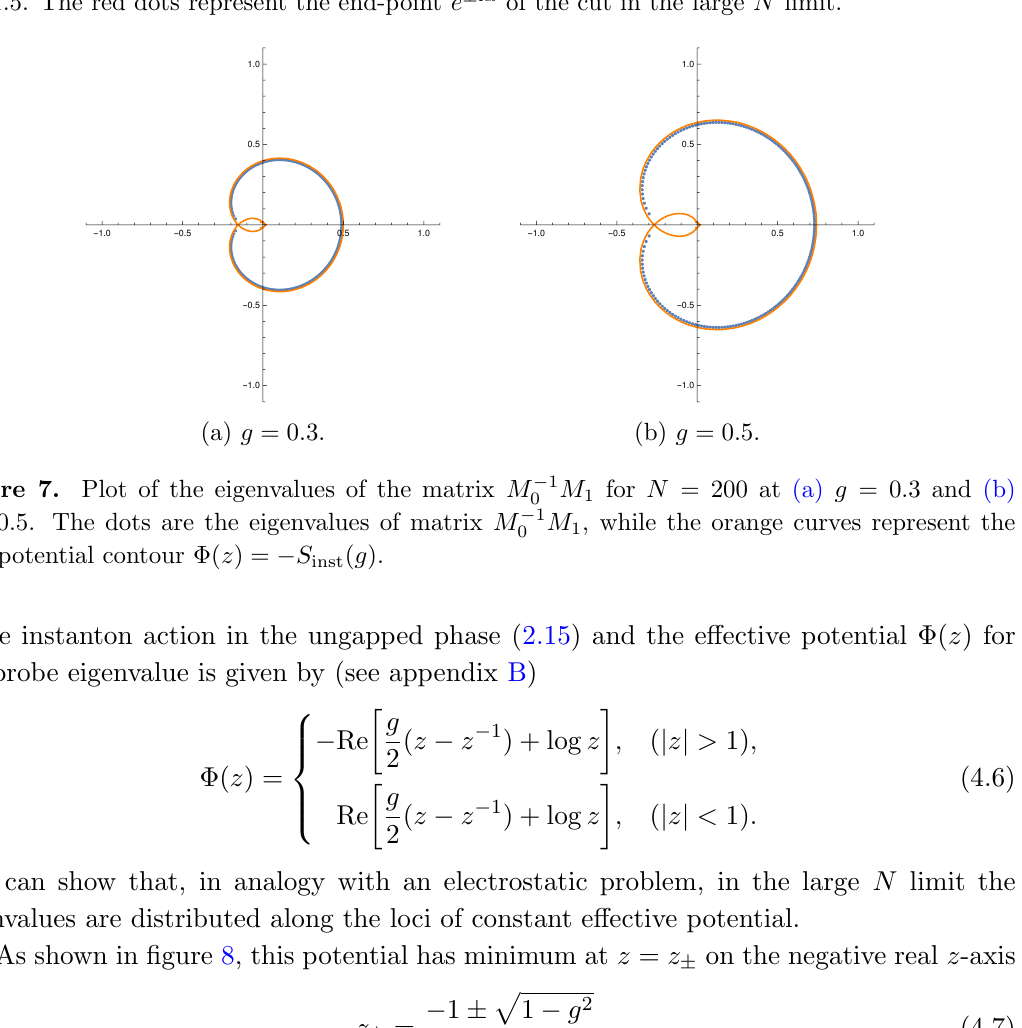
M 1 for N = 200 at (a) g = 1 : 1 and (b) 0